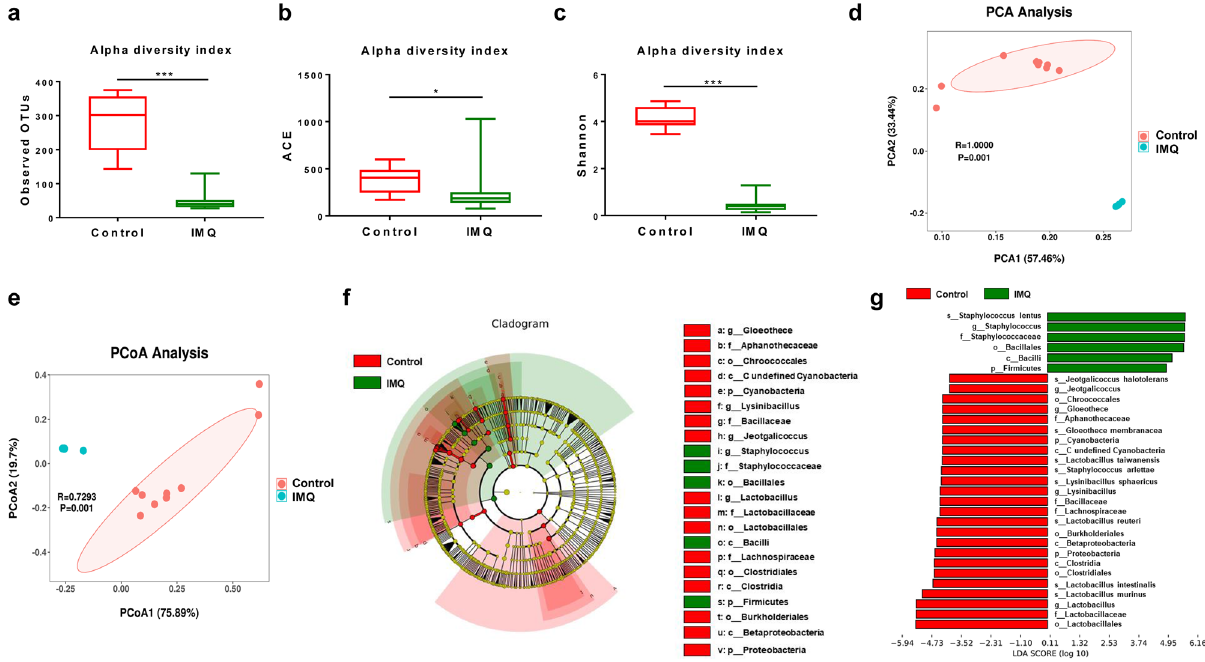
Figure 3. Effects of IMQ on the composition of skin microbiota in alpha-diversity and beta-diversity. ( a ) Alpha-diversity index of observed OTUs (Mann–Whitney U test, U = 0, P = 0.000). ( b ) Alpha-diversity index of ACE (Mann–Whitney U test, U = 20, P = 0.023). ( c ) Alpha-diversity index of Shannon (Mann–Whitney U test, U = 0, P = 0.000). ( d ) PCA of beta-diversity based on the OTU level (ANOSIM, R = 1.000, P = 0.001). Each point represents a single sample color-coded according to group, and the two principal components (PC1 and PC2) explained 57.46% and 33.44%. ( e ) PCoA plot using upon weighted UniFrac distance (ANOSIM, R = 0.7293, P = 0.001). Each point represents a single sample and the two principal components (PCoA1 and PCoA2) explained 75.89% and 19.7%. ( f ) LEfSe cladogram (LDA score > 4.0, P < 0.05) indicated differentially abundant taxa between control group and IMQ group. Each circle represents the taxonomic categories from the species level as the outermost circle to phylum level as the innermost cycle. ( g ) Histograms revealed differentially abundant taxa with LDA score (log10) > 4.0 and P < 0.05 between the control group and IMQ group. The LDA scores of the control group was negative, while those of the IMQ group was positive. The values represent